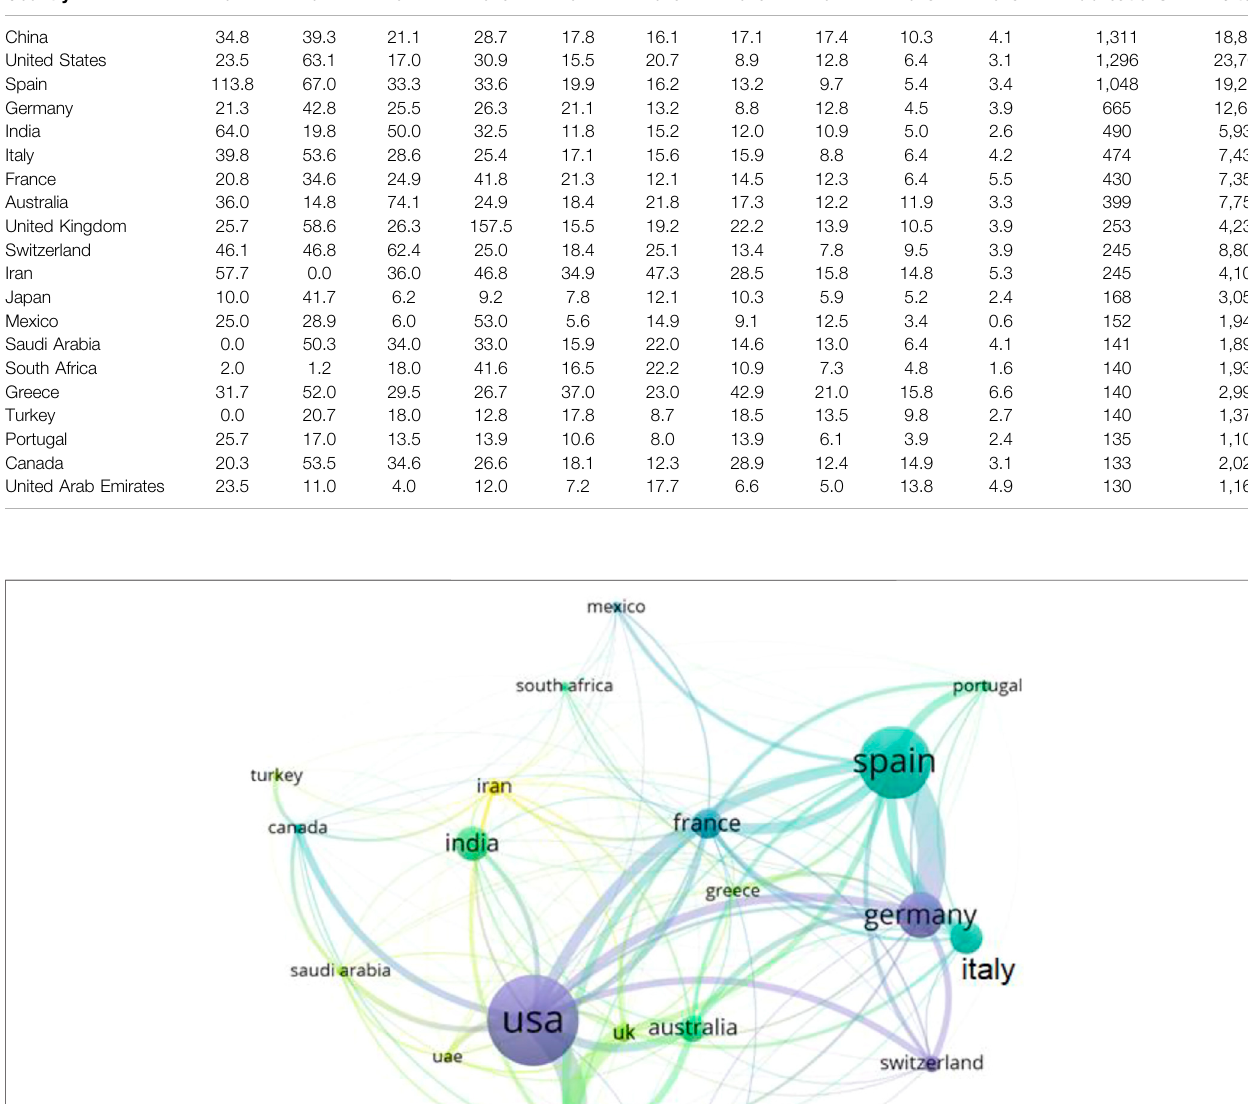
TABLE 4 | Country performance ratio of CSP publications per year for the last 10 years. Country